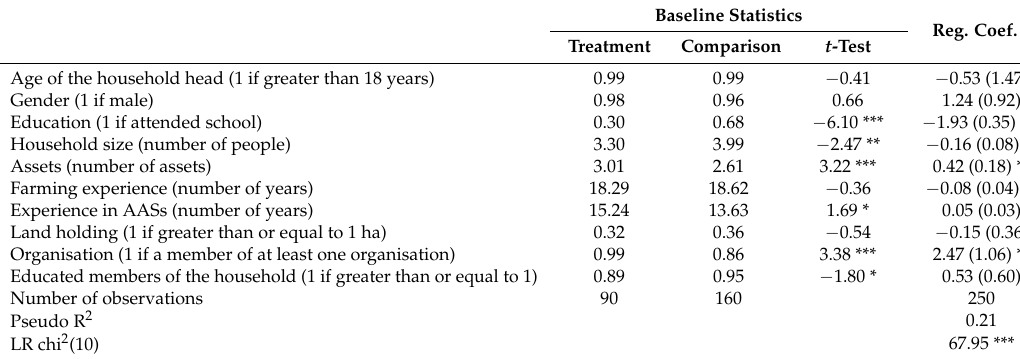
Table 4. Baseline data on covariates by treatment group and logistic regression